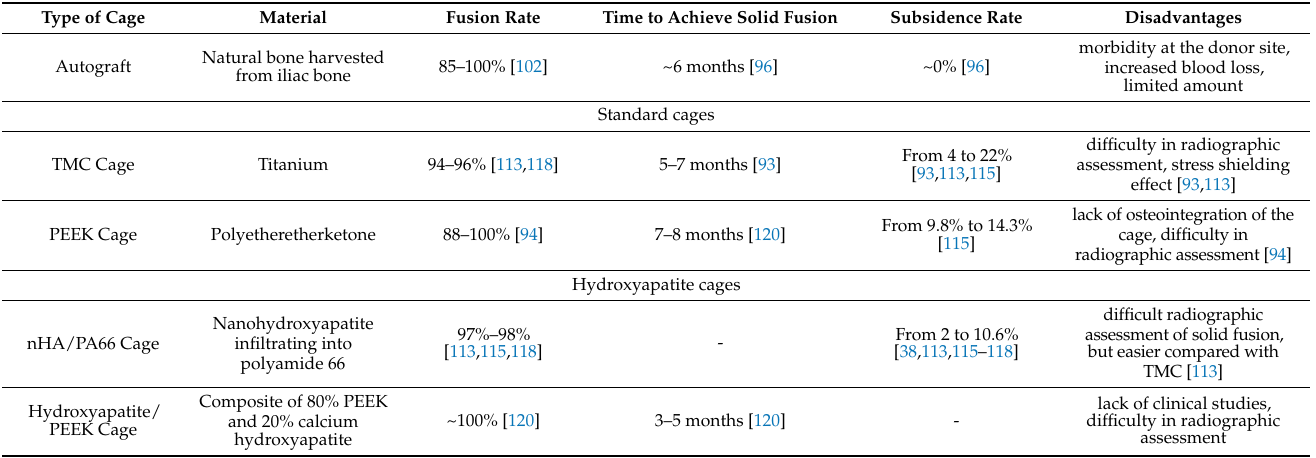
Table 1. Comparison of the hydroxyapatite cages with other cages used in